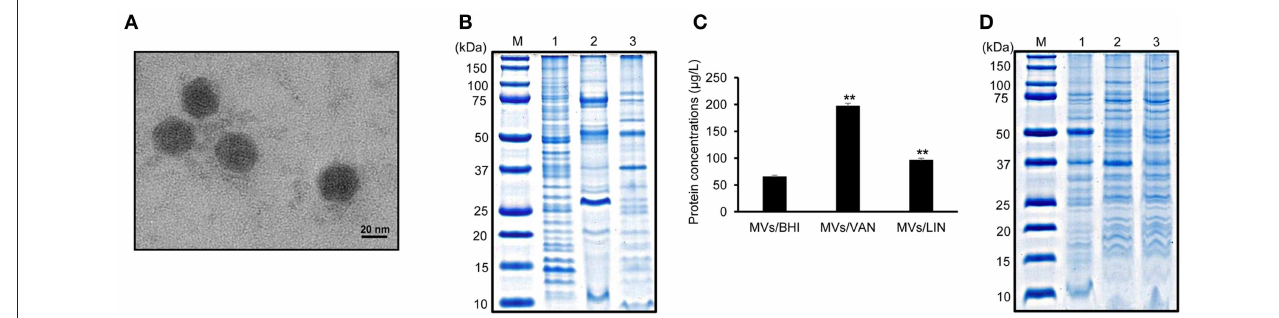
FIGURE 1 | Membrane vesicles (MVs) produced by E. faecium ATCC 700221 cultured with or without antibiotics. (A) Transmission electron micrographs of MVs from E. faecium cultured in BHI broth. (B) SDS-PAGE analysis of proteins obtained from bacterial lysates (lane 1), culture supernatant (lane 2), and MVs (lane 3). Bacteria were cultured in BHI broth to late exponential phase. Lane M, molecular weight marker. (C) Production of MVs from E. faecium cultured with or without antibiotics. MVs were isolated from E. faecium cultured in BHI broth (MVs/BHI), BHI broth with 256 µ g/ml vancomycin (MVs/VAN), or BHI broth with 1 µ g/ml linezolid (MVs/LIN). The protein concentration of MVs isolated from 1L of bacterial culture was measured using a modified BCA assay. Data are presented as the mean ± SD of three independent experiments. ** P < 0.01 compared to MVs/BHI. (D) SDS-PAGE analysis of MV proteins. Lane M, molecular weight marker; 1, MVs/BHI; 2, MVs/VAN; 3, MVs/LIN. (A,B,D) represent one of three independent experiments.